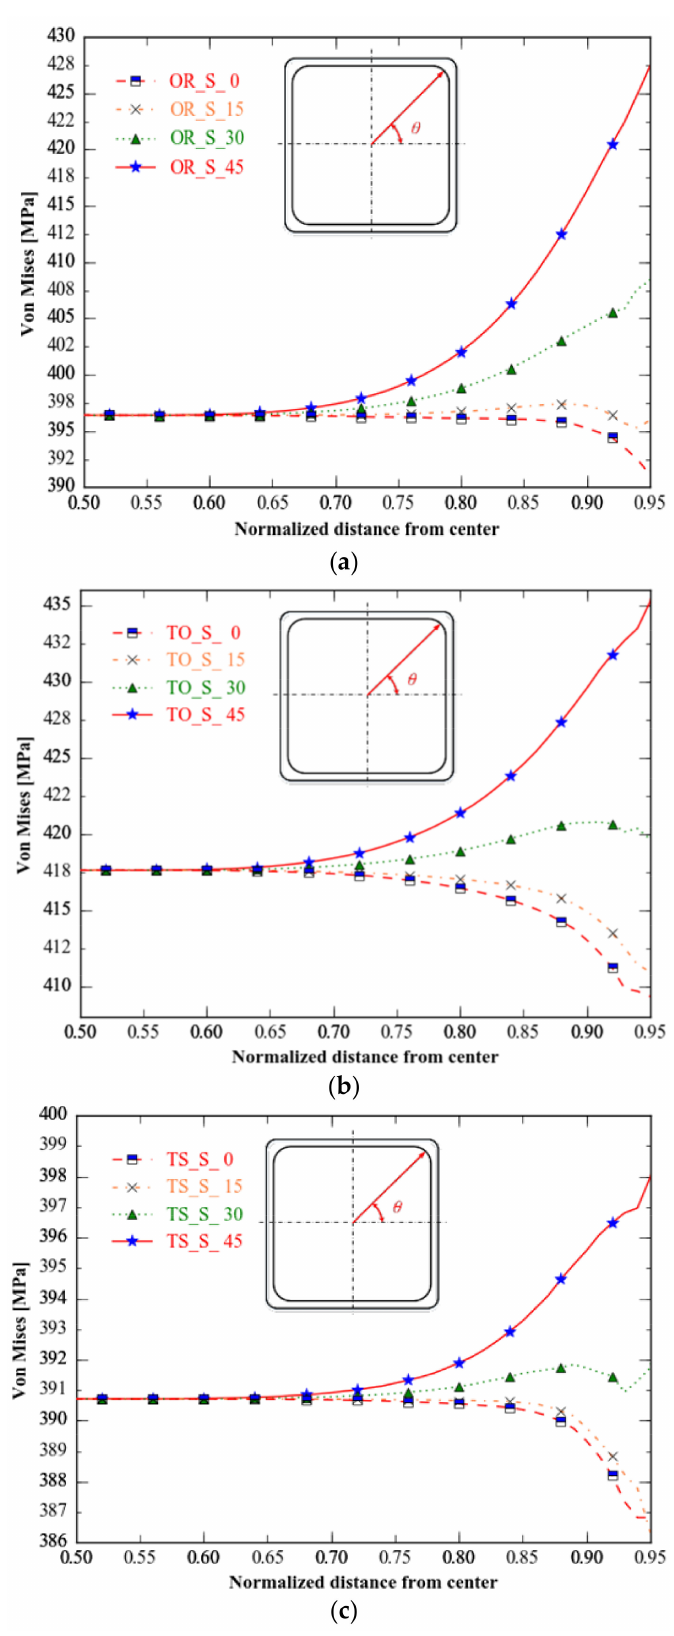
Figure 14. von Mises of the three specimens in four directions. ( a ) Type A: unoptimised specimen; ( b ) type B: specimen with topology-only optimization; ( c ) type C: specimen with topology combined with shape